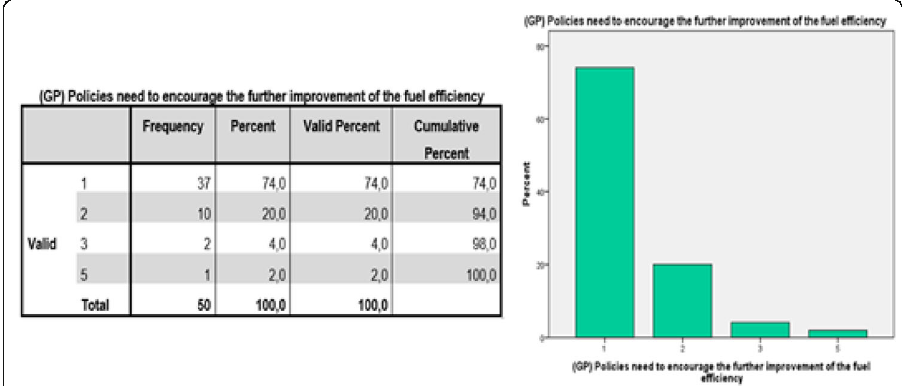
Fig. 6 Policies should encourage a further improvement in the efficiency of both technologies. Source: by